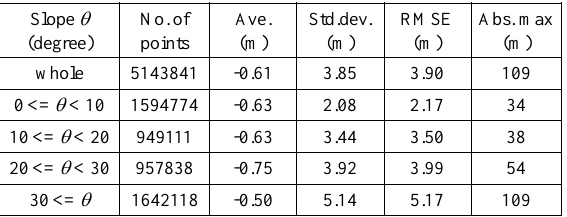
Figure 9. The ORI (upper), the DSM tile data shaded relief (middle), and the difference image between the tile DSM data and the airborne LiDAR/DSM (lower) on the 8 km x 8 km Table 6. Stats of height difference between the DSM tile data and the airborne LiDAR/DSM (DSM tile data minus LiDAR) depending on the slope angles